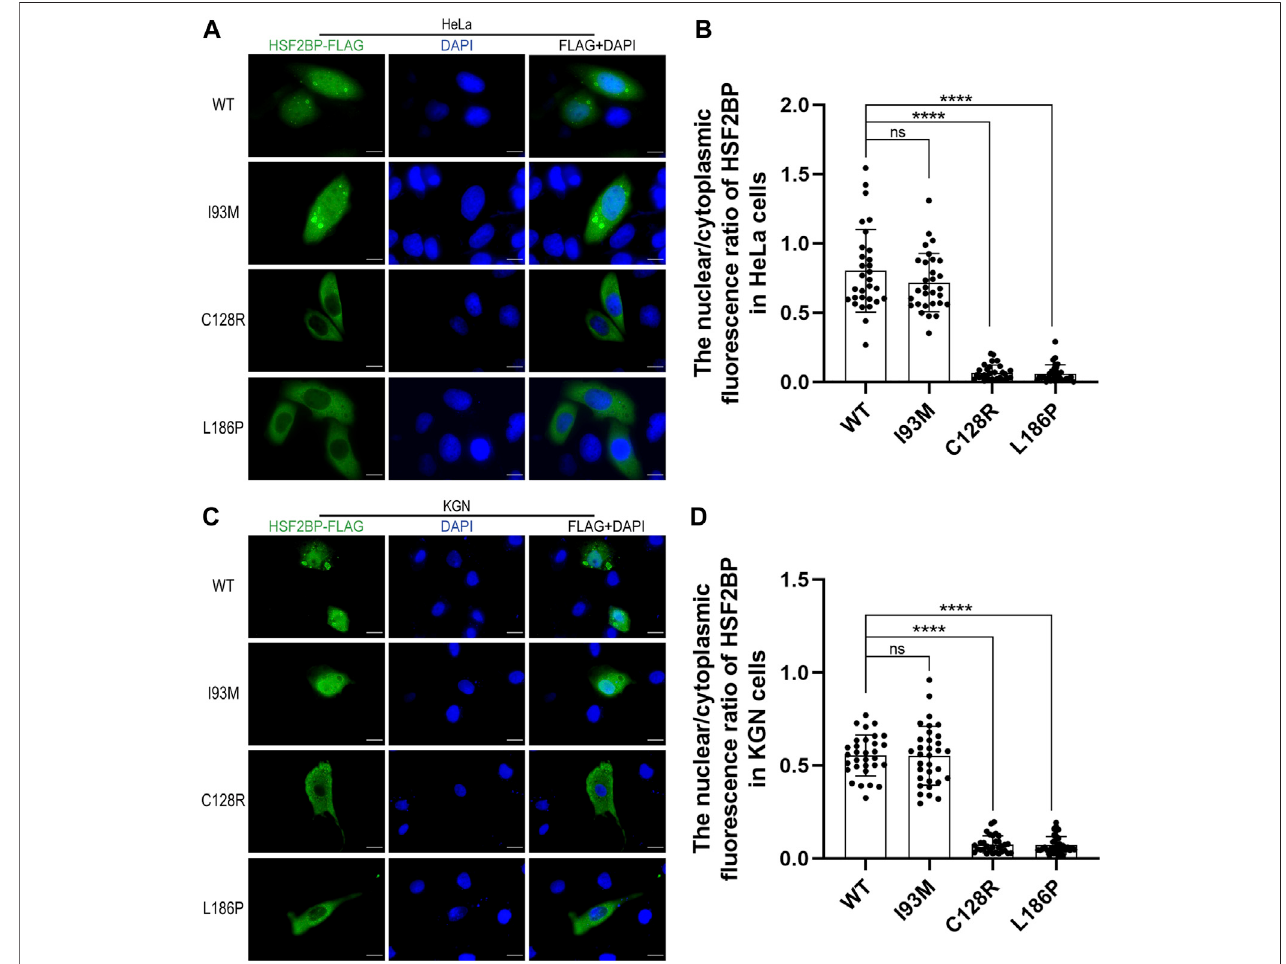
FIGURE 2 | The two variations impaired the nuclear localization of HSF2BP. (A,C) Immuno fl uorescence against FLAG (green) in HeLa cells (A) and KGN cells (C) overexpressingwild-type(WT)ormutantHSF2BP(I93M,C128R,andL186P)plasmids.ThemutantI93Mwasapolymorphismvariantusedasacontrolhere.Thenuclei were counterstained with DAPI (blue). Scale bars are 10 μ m. (B,D) The nuclear vs. cytoplasmic ratio of HSF2BP proteins in HeLa cells (B) and KGN cells (D) . The differences of nuclear vs. cytoplasmic ratio between wild-type and mutant C128R or L186P groups were statistically signi fi cant. **** p < 0.0001.